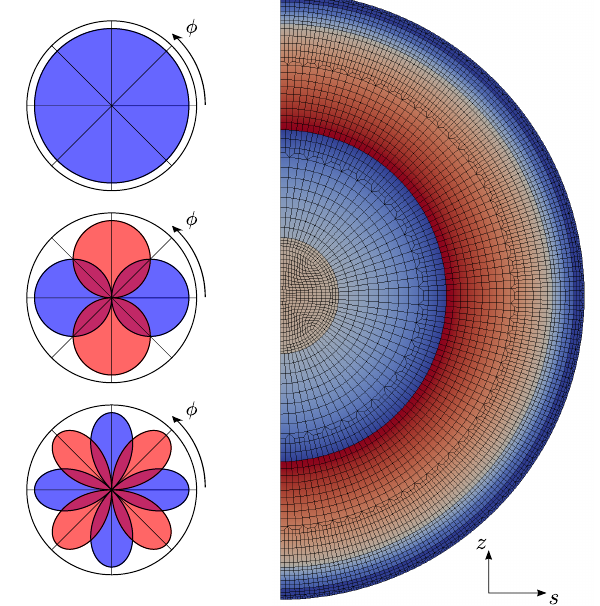
Figure 2. The 3-D wave field is decomposed analytically into monopole, dipole and quadrupole radiation patterns (left) and the remaining 2-D problem is solved on a D-shaped domain (right) us- ing the spectral element method. While the forward databases re- quire a total of four 2-D computations, it is only two for the back- ward databases using reciprocity of the Green’s function: one for the vertical and one for the horizontal components (modified from Nissen-Meyer et al., 2014).